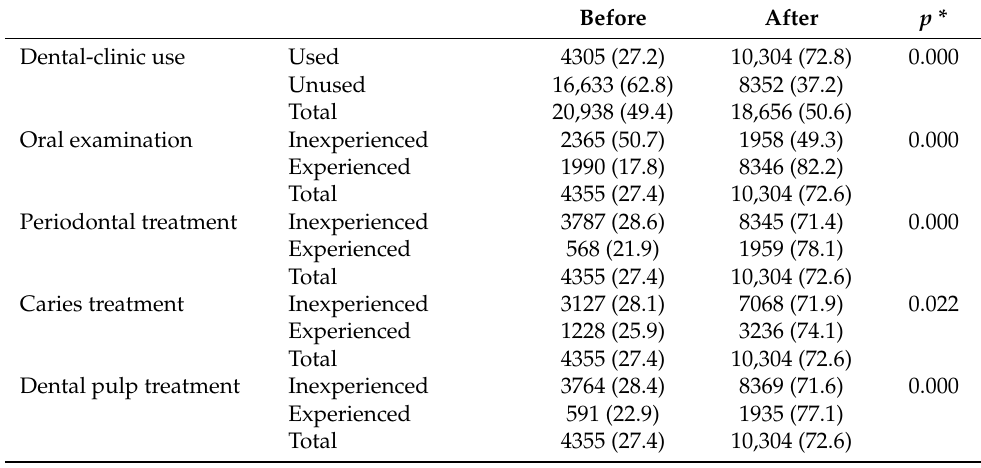
Table 3. Comparison of the subjects’ dental-clinic use (Unit: